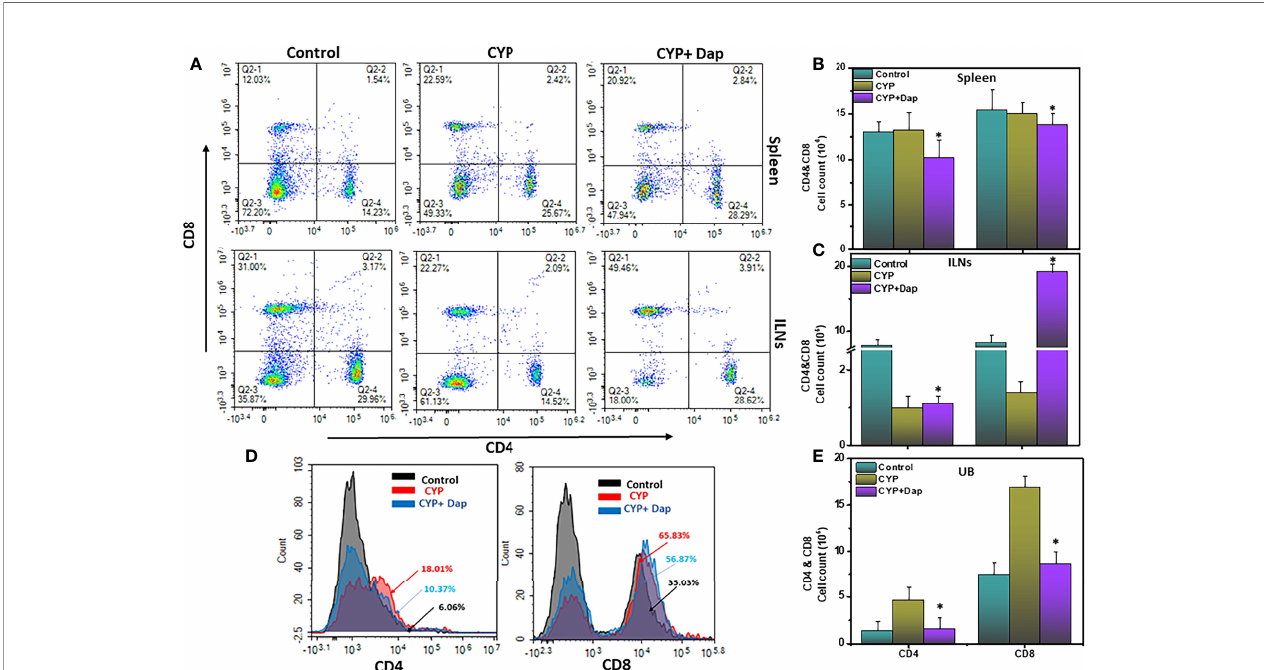
FIGURE 2 | Dap mediates the frequency of systemic and mucosal T cells. Single-cell suspensions from spleen, iliac lymph node (ILN), or UB were isolated from each group on day eight, stained for T cell phenotypic markers, and analyzed by fl ow cytometry. Panels A shows a representative experiment indicating the percentages of CD4 + T cells (A , lower right quadrant ) and CD8 + T cells (A , upper left quadrant ) . (D) shows the percentage of both CD4 + T cells and CD8 + T cells as histogram plots in UBs. (B, C, E) show numbers of CD4 + T and CD8 + T cells in the spleen, ILNs, and UBs respectively. Data shown in (B, C, E) represent the total number of these cells ± SEM from three independent experiments involving six mice per group (n=18). Asterisks indicate statistically signi fi cant differences between CYP+vehicle and CYP+Dap treated groups (*p < 0.05).